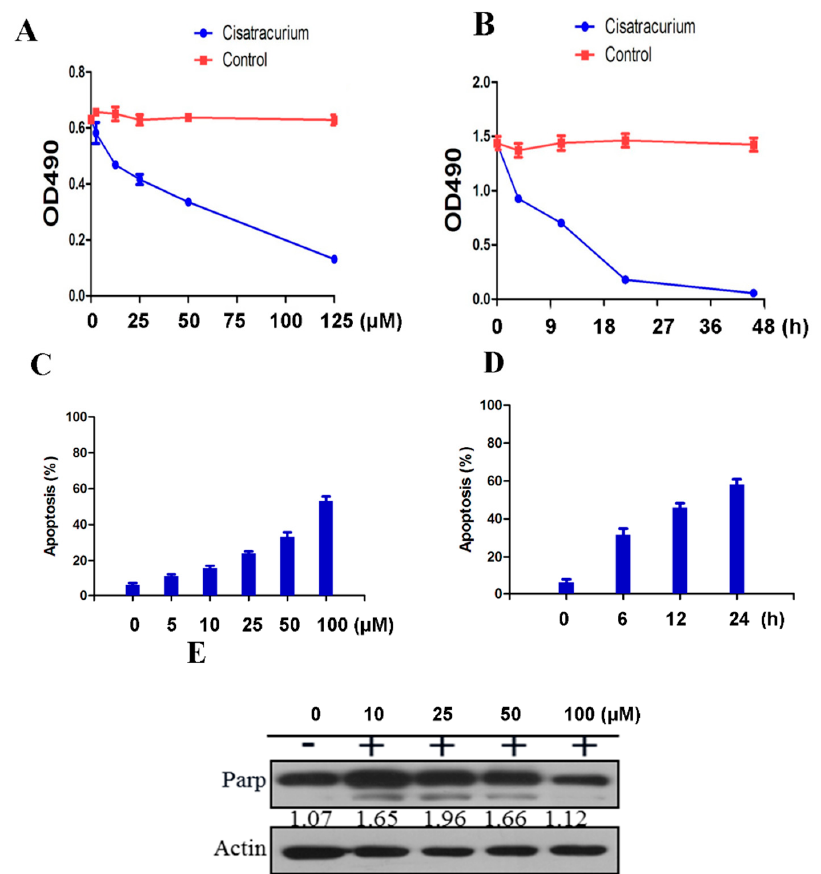
Figure 3. Cisatracurium causes inhibition of cell proliferation and induction of cell death. ( A ) HUVEC was incubated with cisatracurium (0, 5, 10, 25, 50, or 125 µM) for 12 h. Cell viability was analyzed by CCK assay; ( B ) HUVEC was incubated with cisatracurium (10 µM) for 0, 6, 12, 24, or 45 h. Cell viability was analyzed by CCK assay; ( C ) HUVEC was incubated with cisatracurium (0, 5, 10, 25, 50, or 100 µM) for 12 h. Cells were stained by PI and Annexin-5 and then analyzed by flow cytometry to calculate the rate of apoptosis. Data are presented as mean ± SD from three independent experiments. p < 0.01; ( D ) HUVEC was incubated with cisatracurium (5 µM) for 0, 6, 12, or 24 h. Cells were stained with PI and Annexin-5, then analyzed by flow cytometry to calculate the rate of apoptosis. Data are presented as mean ± SD from three independent experiments. p < 0.01; ( E ) HUVEC was incubated with cisatracurium (0, 10, 25, 50, 100 µM) for 12 h. Samples were then subjected to immunoblot using antibodies against PARP or β -actin. Numbers indicate the normalized optical density ratio of cleaved PARP to β -actin. Data are presented as a representative image from three independent experiments.